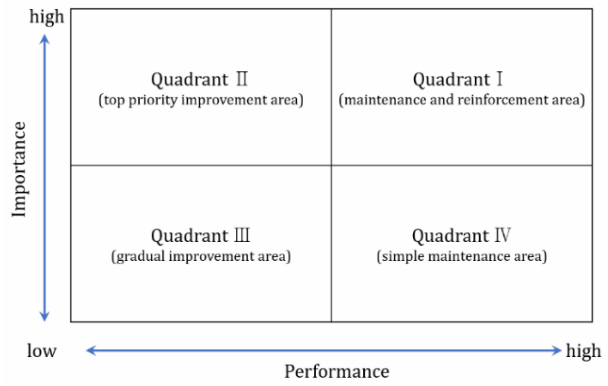
Figure 2. IPA quadrant